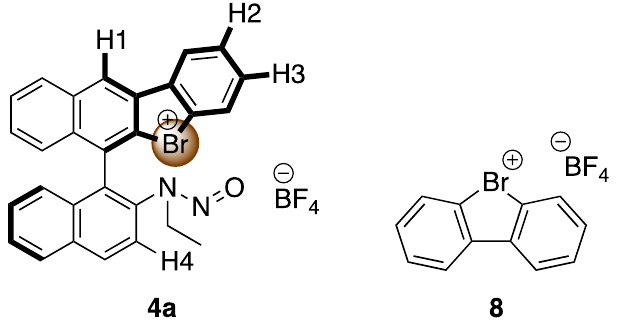
Figure 3. Structure of 4a and 8 .